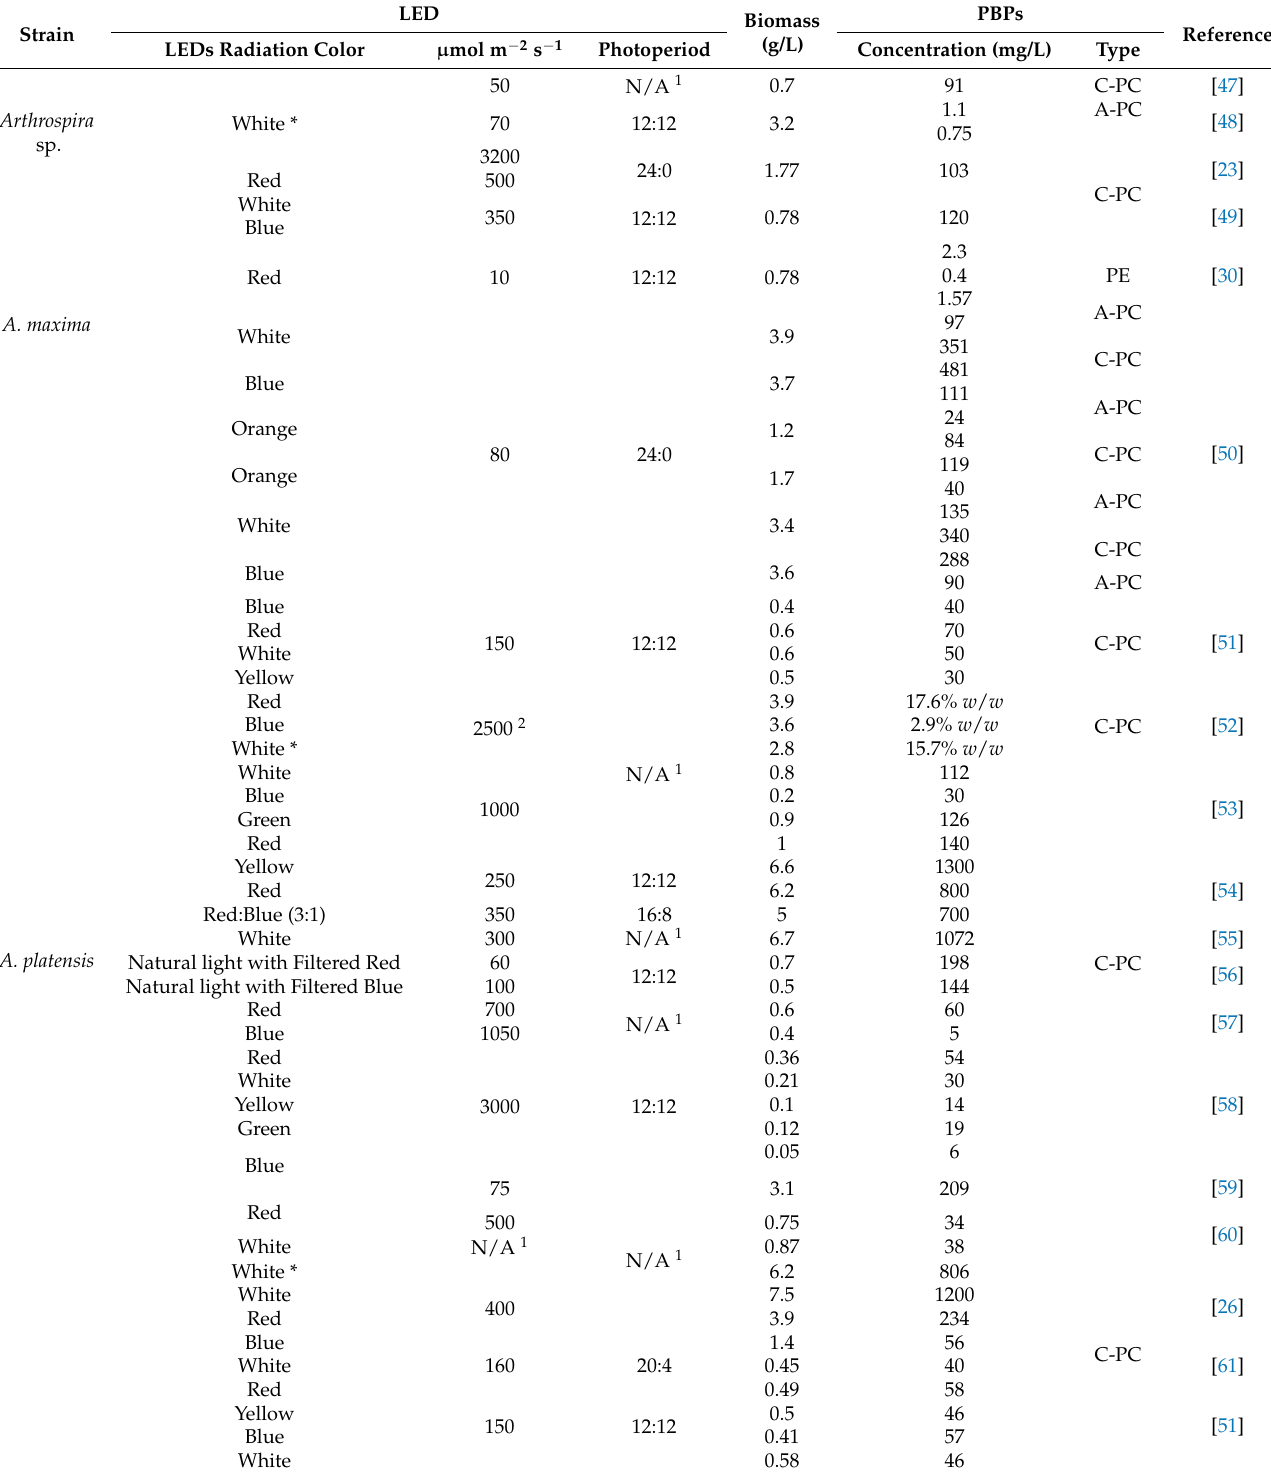
Table 1. Strains of cyanobacteria produced under different LEDs colors for PBPs